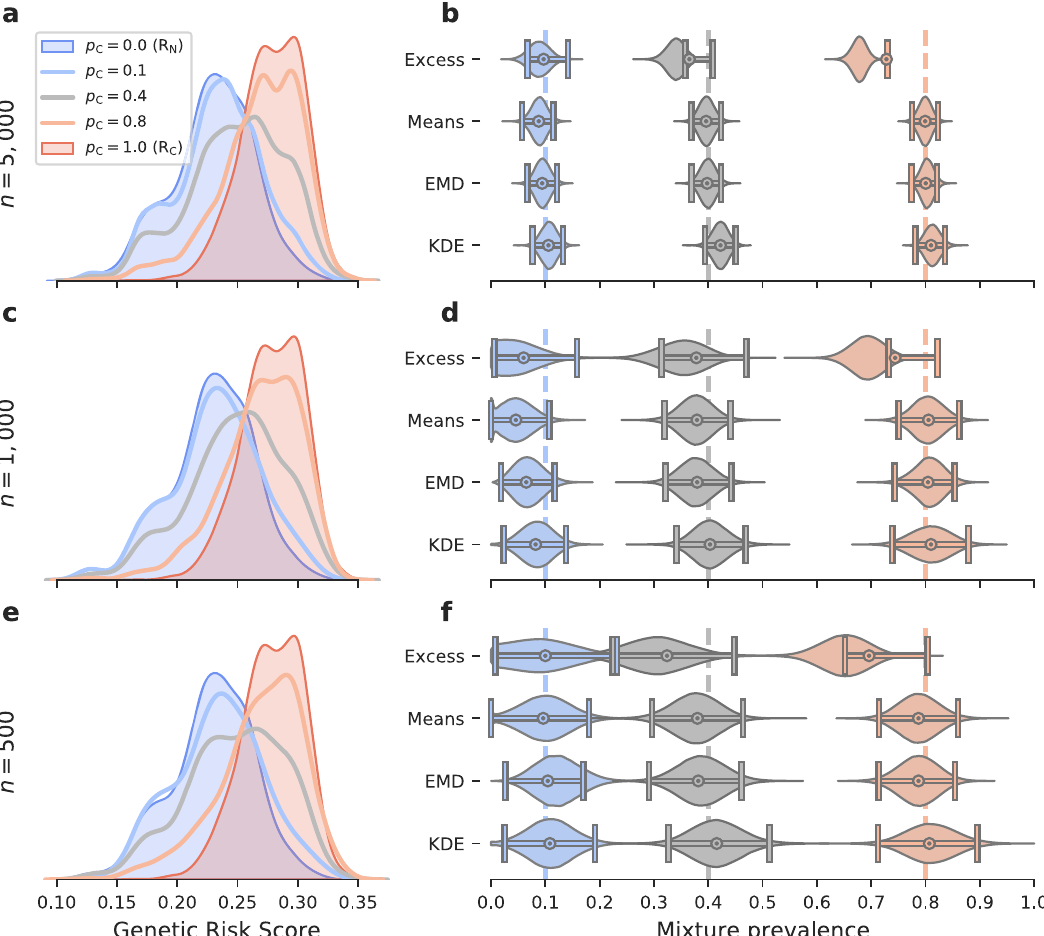
Fig. 2 A comparison of the four methods prevalence estimates and con fi dence intervals for varying proportion of cases and for three sample sizes. Mixture distributions of non-cases and T1D patients from WTCCC 8 were constructed with p C ¼ 0 : 1 ; 0 : 4 ; 0 : 8 f g (shown in blue, grey and red respectively) and n ¼ 500 ; 1000 ; 5000 (shown in panels ( e – f ), ( c – d ), ( a – b ) respectively). a , c , e The constructed mixture distributions and reference distributions (R shaded red and R N , shaded blue) from which they were constructed. b , d , f Prevalence estimates, ^ p C (bullseye) obtained by each of the four methods for varying p C ( x -axis) and cohort size, n (rows). Each estimated ^ p C value is shown together with a violin plot illustrating the distribution of the 100,000 estimates of prevalence ( p 0 ) in the bootstrap samples and with con fi dence intervals ( α ¼ 0 : 05) shown as horizontal lines with vertical bars at the ends. C Dashed vertical lines indicate reference prevalence values p C . In all the cases, for the Excess method we observe a large offset between the violin plots (including con fi dence intervals) and the ^ p C value. This offset is a result of the systematic bias of the Excess method. The other three methods generally show much less bias. Sample sizes: R C – cases WTCCC T1D ( n ¼ 982), R N – non-cases WTCCC T2D ( n ¼ 962), mixtures – sampled with replacement from a holdout half of the R C ( n ¼ 981) and R N ( n ¼ 962) and is therefore enriched for T2D risk variants. As shown in Supplementary Fig. 1 the distribution of T2DGRS of unselected T2D cases from population data in UK Biobank is signi fi cantly lower than the T2DGRS in the WTCCC T2D reference. The T2DGRS in UK Biobank population T2D cases only becomes equivalent to the WTCCC when the same case selection criteria are mirrored. If this WTCCC cohort was used as a reference T2D population when evaluating the prevalence of T2D in a cohort in the UK biobank, it would have in fl uenced the accuracy of estimates since it does not constitute a representative T2D cohort.